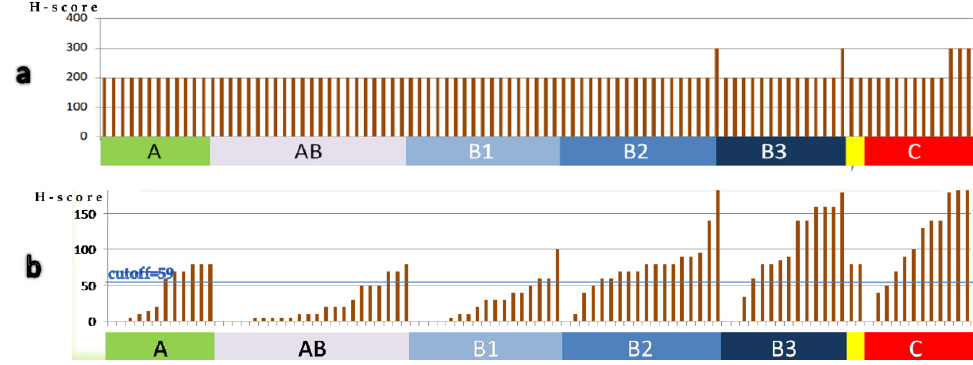
Figure 3. There is higher epithelial EphA4 ( a ) and cytoplasmic epithelial EphA6 ( b ) H-score in epithelial-rich subtypes. Each bar represents one case. Cases were arranged by increasing H-score in each diagram.